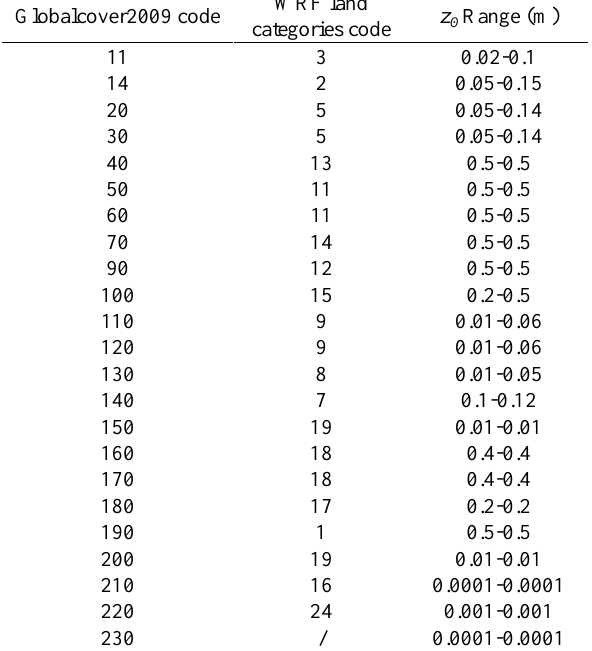
Table 2. The correlation table between Globalcover2009 categories and surface roughness